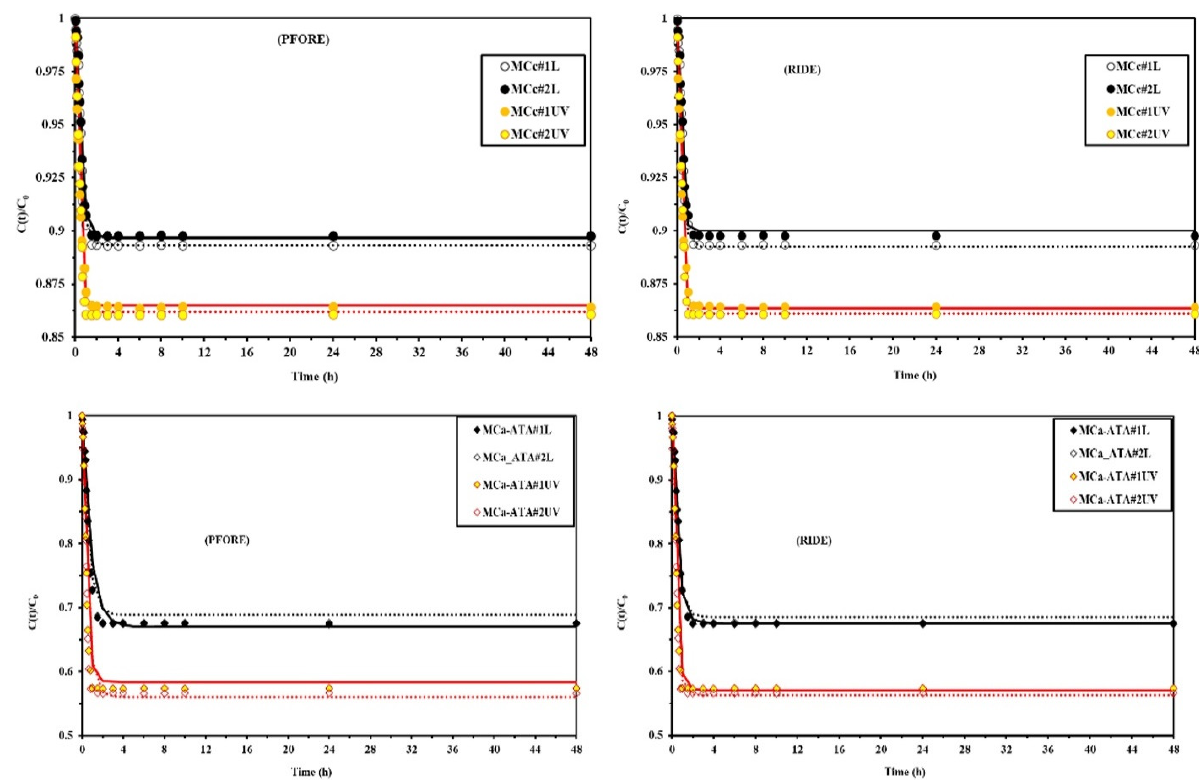
Figure 6. Uptake kinetics of the MCc and MCa-ATA for PFOR and RID equations under the effect of visible light and UV . Table 2. Parameters of the uptake kinetics for MCc and MCa-ATA in visible light (L) and UV ef- fect.